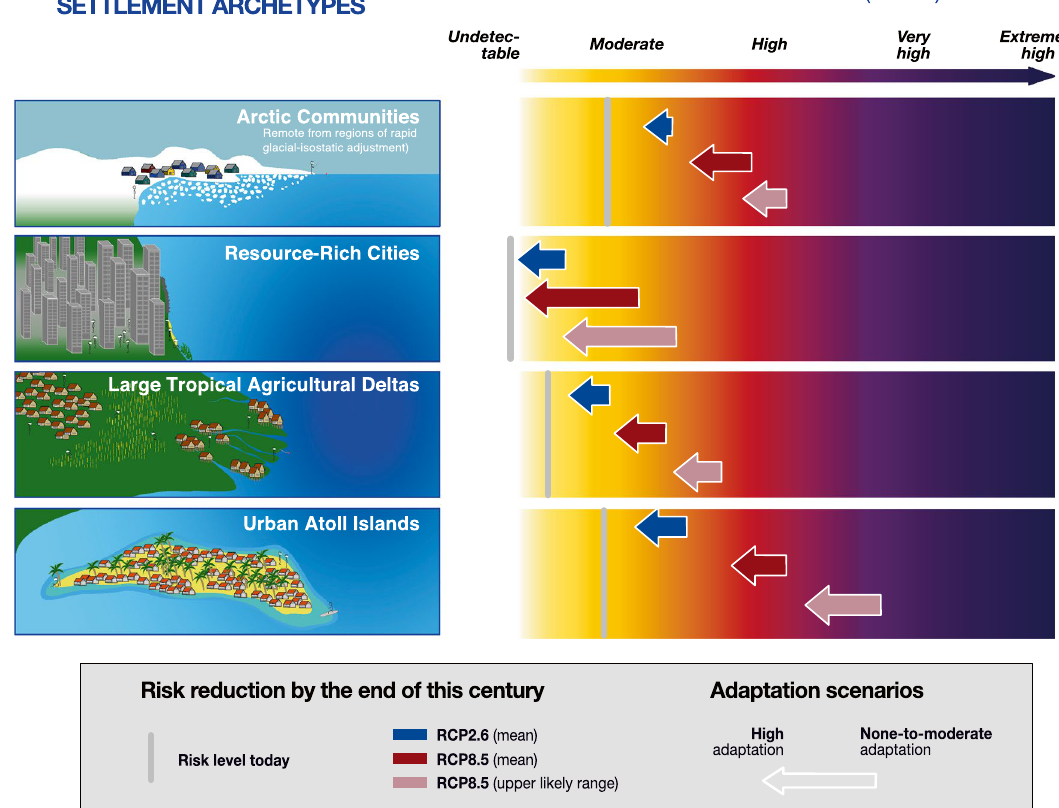
study. The right-hand side uses the same material as in Fig. 3 (see Table 2 and SM2) to display risk levels under various sea level rise scenarios associated with global warming scenarios, and two adaptation scenarios (none- to-moderate versus